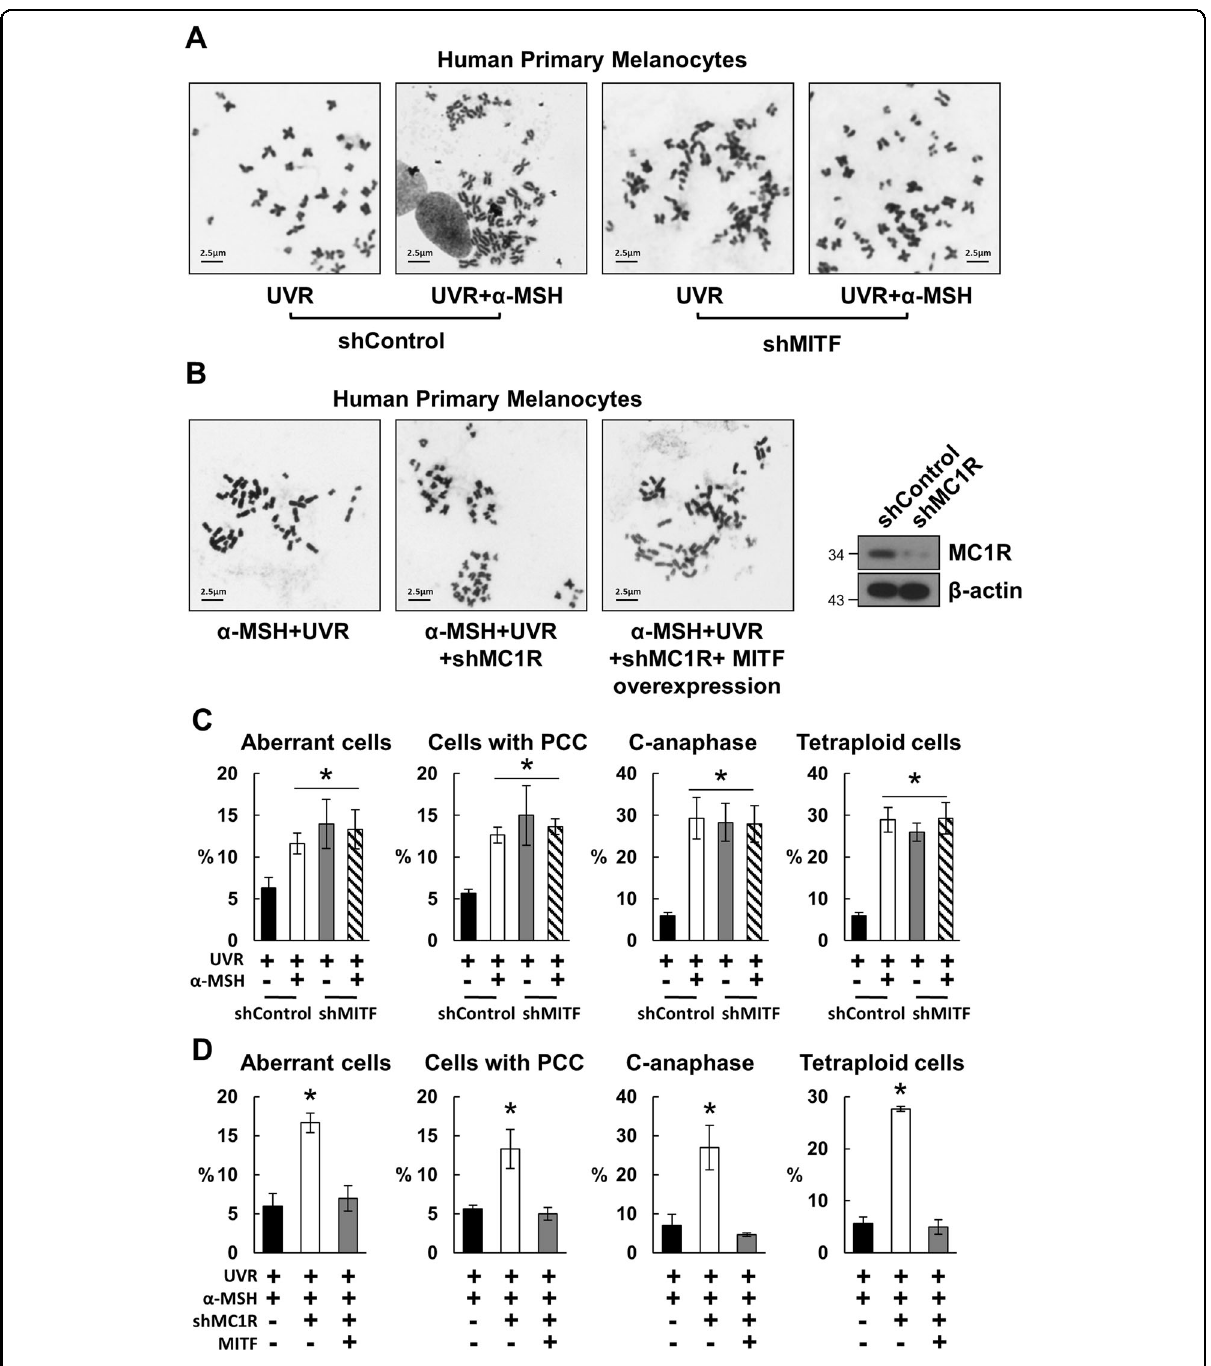
Fig. 4 Mitf is required in α -MSH/MC1R-controlled chromosome stability after UVR. A , B Metaphase spread was performed in HPMs with Mitf knockdown ( A ) or Mitf overexpression ( B ). The cells were then irradiated with 100 J/m 2 UVB. Representative images are displayed. C , D Graphs illustrating the percentage of cytogenetic abnormalities in A and B from three independent experiments. n = 50, Error bars represent